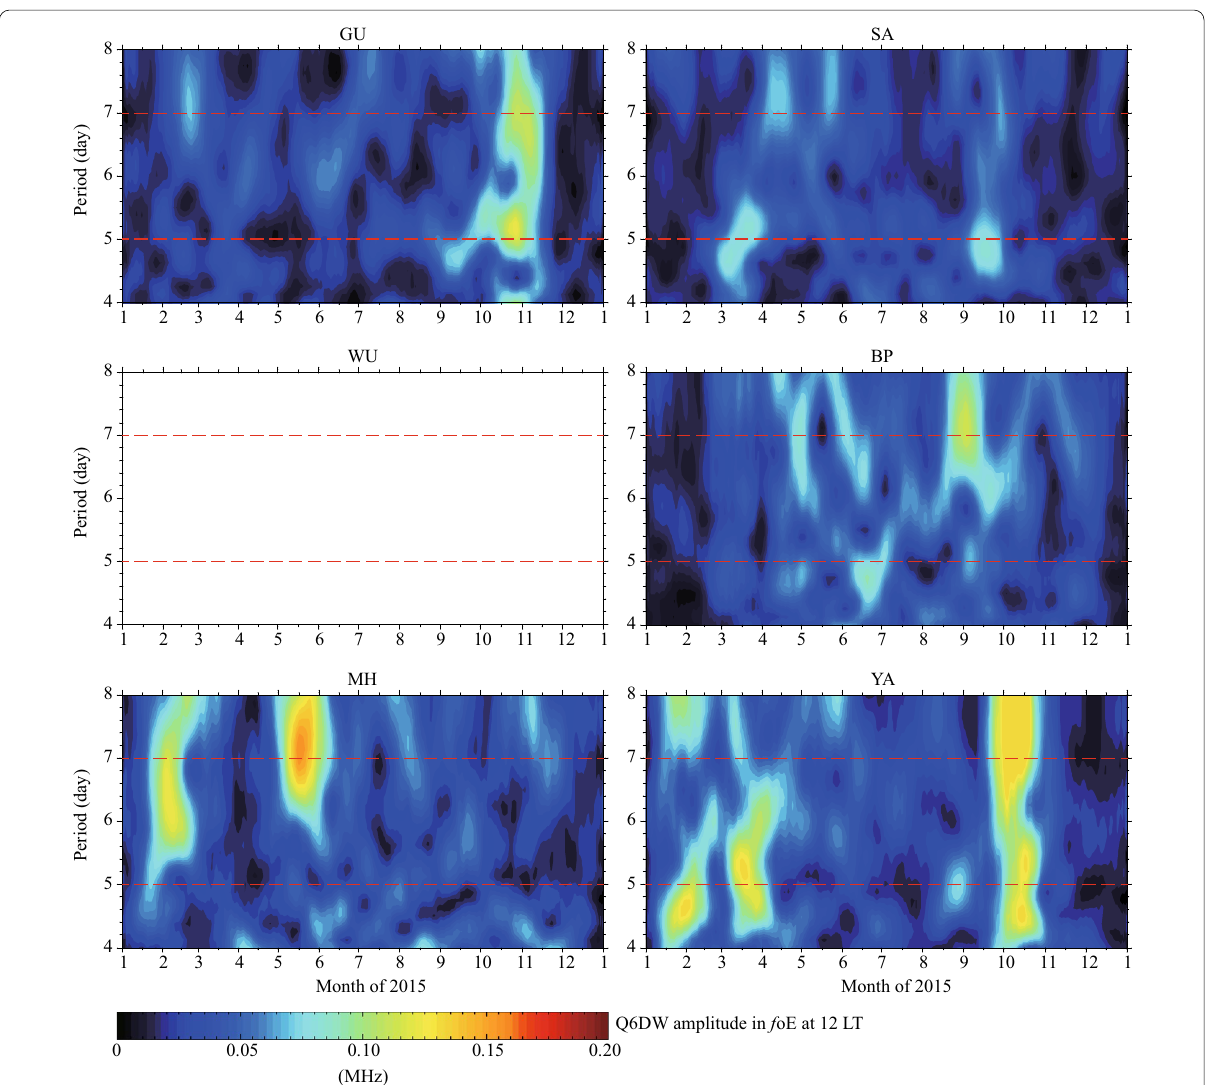
Fig. 6 The time variations of the f oE spectrum at 12:00 LT during 2015 at Guam (GU), Sanya (SA), Wuhan (WU), Beijing (BP), Mohe (MH) and